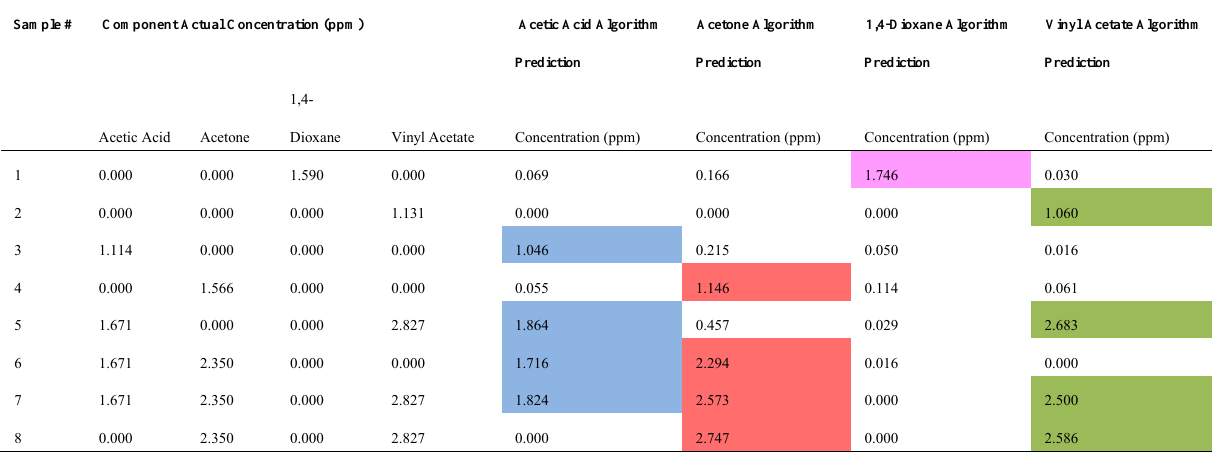
Table 4. PLS2 model predictions for acetic acid, acetone, 1,4-dioxane, and vinyl acetate validation and mixture samples based on 4 PCs. Positive analyte identifications are